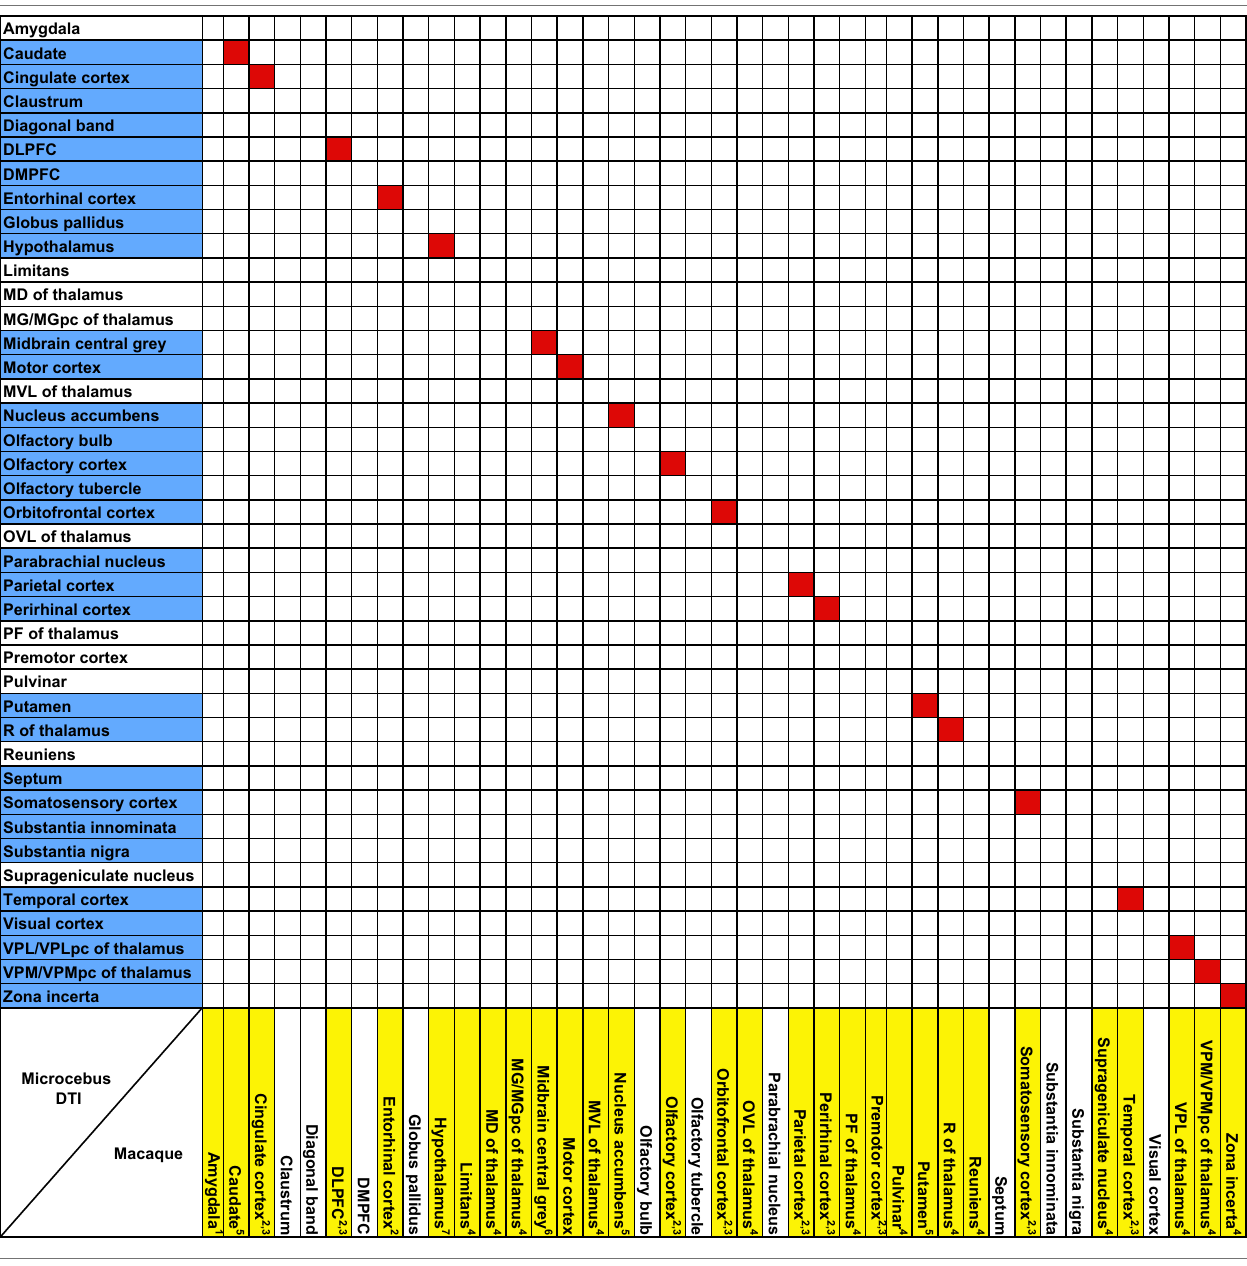
Table 5 | Comparison of insular connectivity in the rhesus macaque ( Macaca mulatta ) and the Microcebus . Amygdala